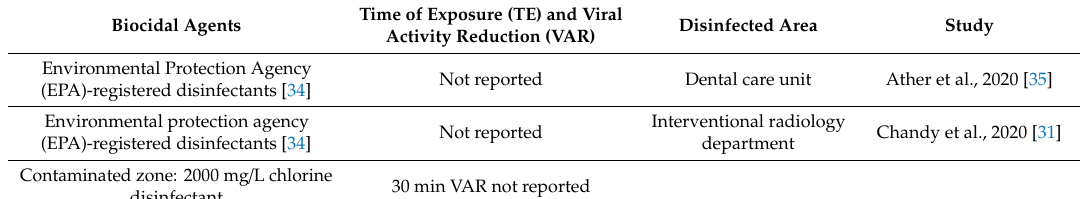
Table 1. Results of individual studies: biocidal agents proposed by the included articles, time of exposure / viral activity reduction of each disinfectant, and area in which the disinfection was performed. Biocidal